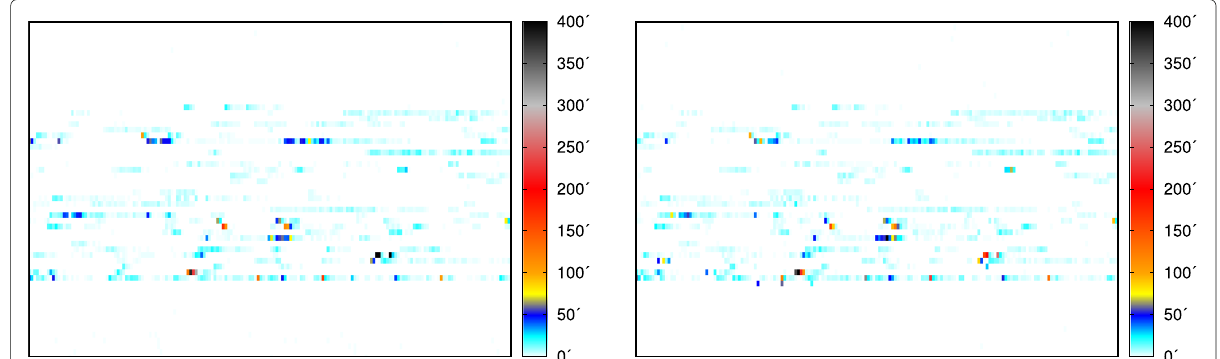
Fig. 2 Cache accesses made by Face during two different executions. The figure shows the cache hits made during cache obfuscation represented in the form of a heat map. They depict approximately 10,800 addresses in a 10MB last-level cache in a 180 x 60 grid. This is just to show that the hits